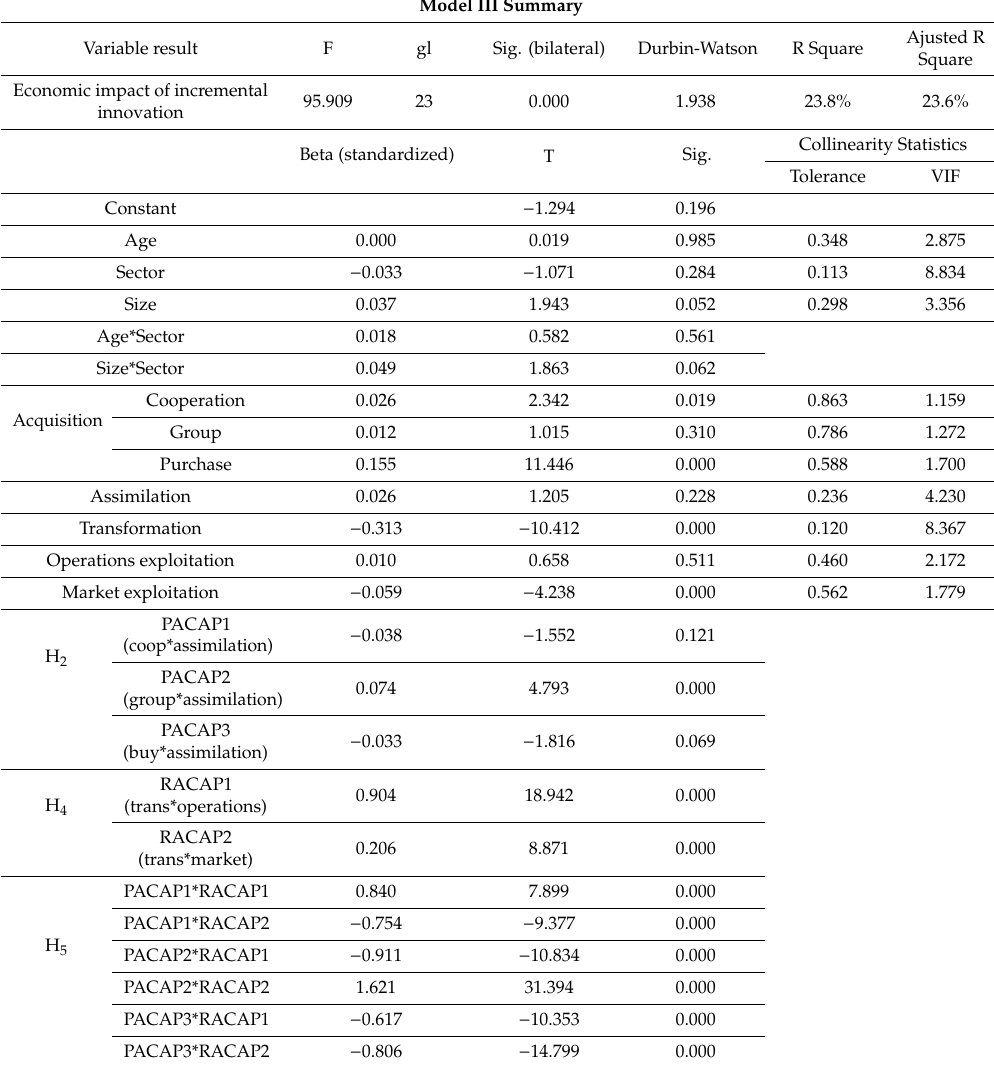
Table 5. Absorptive routines, PACAP, RACAP and economic impact of incremental